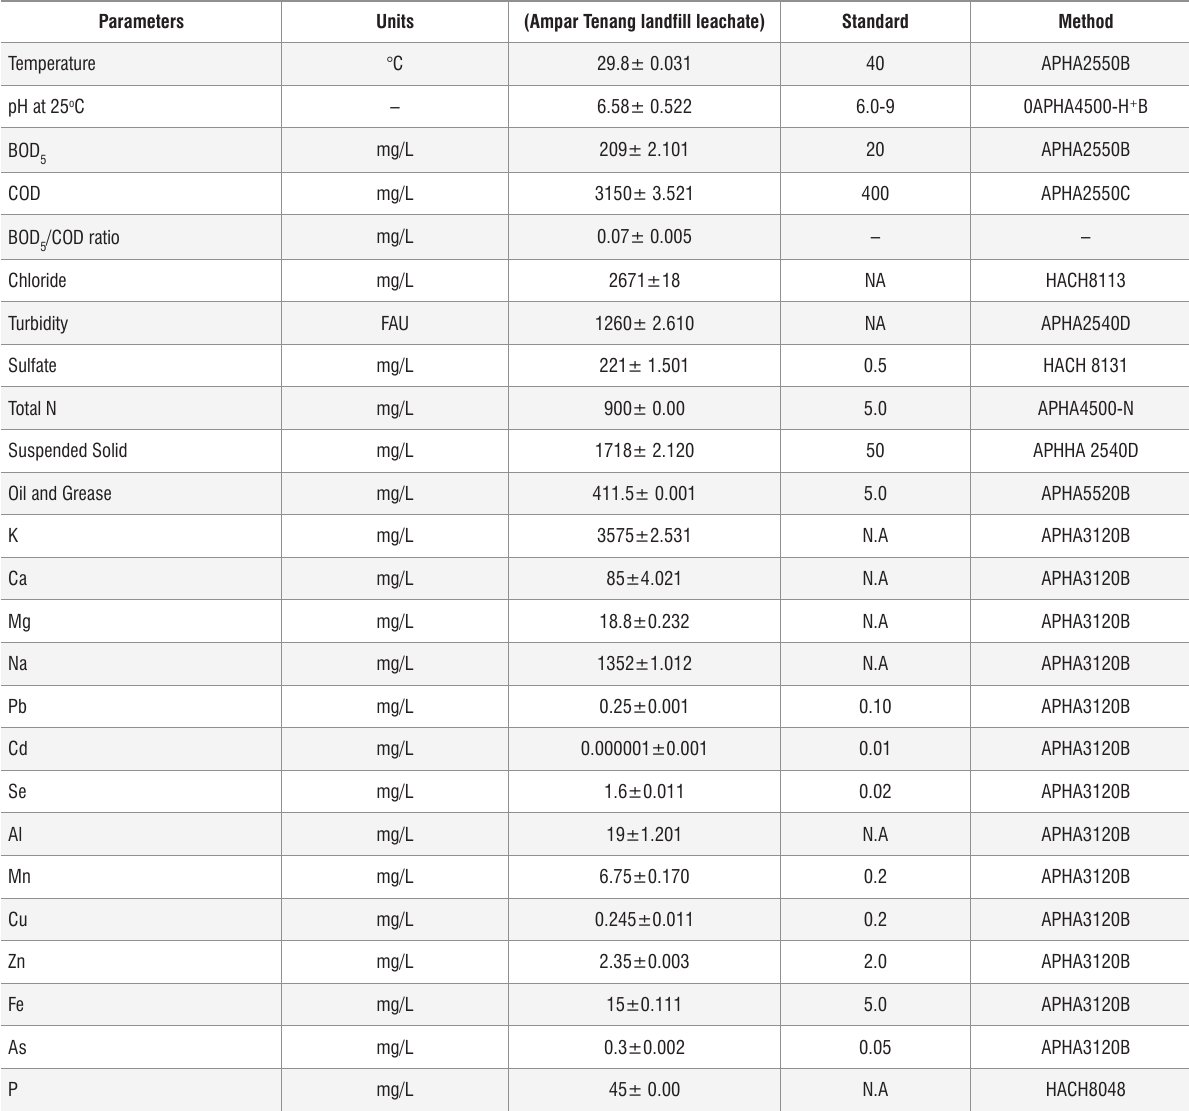
Characteristics of untreated leachate samples from Ampar Tenang landfill compared with Environmental Quality (Control of Pollution from Solid Waste Transfer Station and Landfill) Regulation 2009 Malaysia 49 : Acceptable conditions for discharge of leachate.